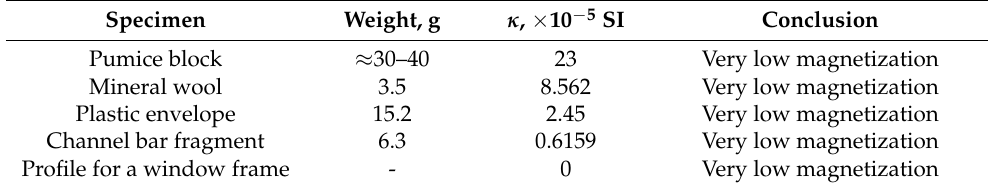
Table 4. Magnetic properties of some construction materials for the Gyulagarak observatory.